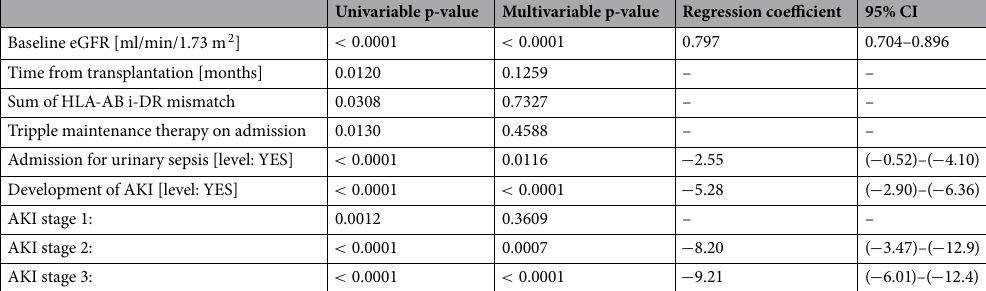
Table 7. Multivariable linear regression model for predictors of eGFR at 1-year post-discharge. Adjusted for the time from transplantation, amount of HLA mismatches and tripple mainenance therapy. Adjusted R2 = 0.6478; 95% CI 0.5803–0.7153; p < 0.0001